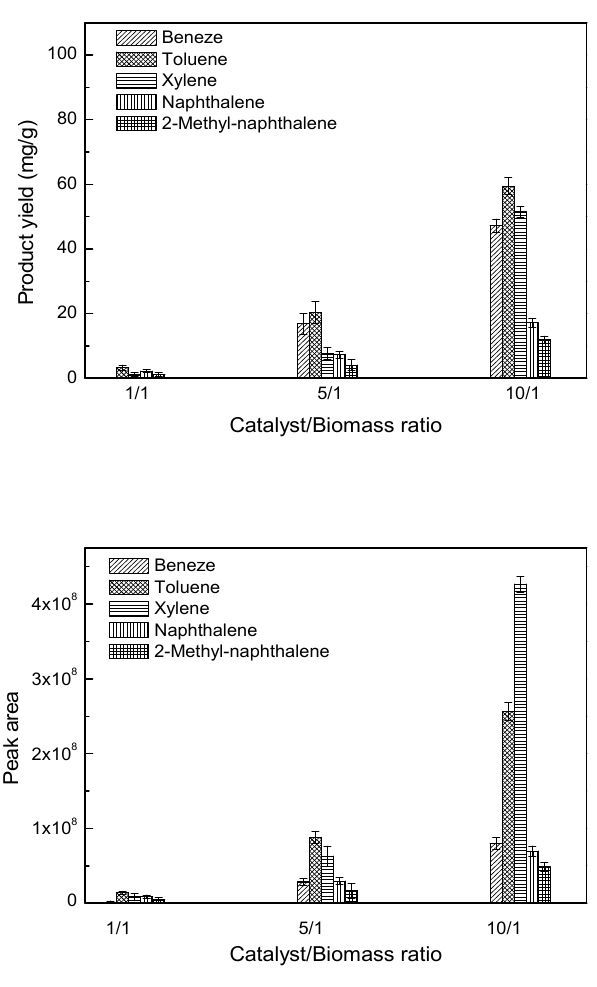
Figure 7. The actual yields of five major aromatic hydrocarbons (10Mo/ZSM-5, T = 600 °C).